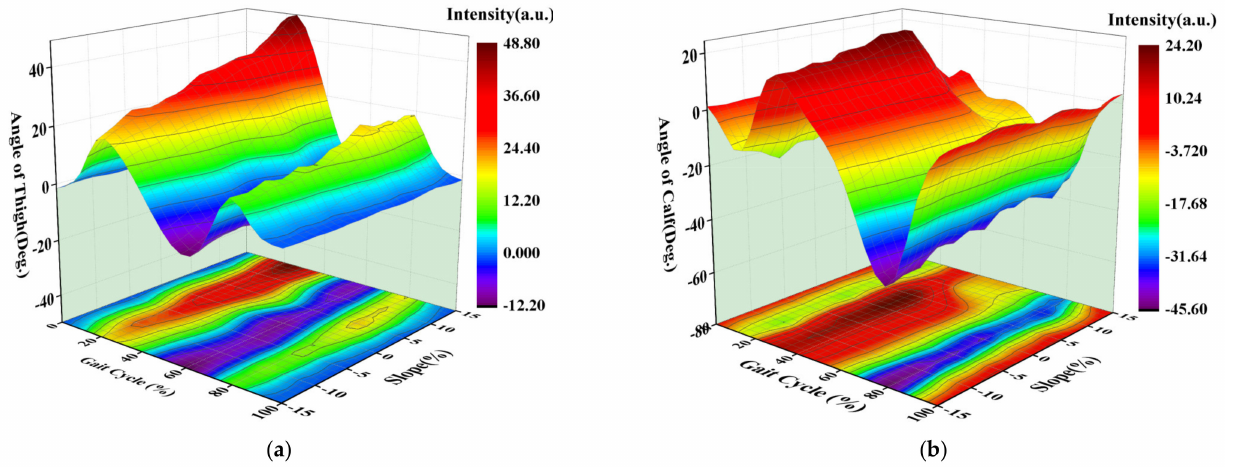
Figure 5. Angle of the lower limb on different slopes. ( a ) Thigh angle on different slopes; ( b ) calf angle under different slopes. Therefore, the difference in slope is mainly reflected in the first peak of the thigh angle. There is a positive linear correlation between the slope and the peak angle of the thigh. This is determined by the gait characteristics. The peak of the thigh angle appears at the beginning of the support phase; when the foot touches the ground, the thigh angle reaches the maximum, then decreases. Figure 6 illustrates the thigh angle α of the test leg under different slopes during gait movement. The following conclusions can be drawn from Figure 6: when the slope increases, the center of gravity of the calf and foot becomes higher at the beginning of the support phase, which makes the thigh rotate more counterclockwise around the hip joint.